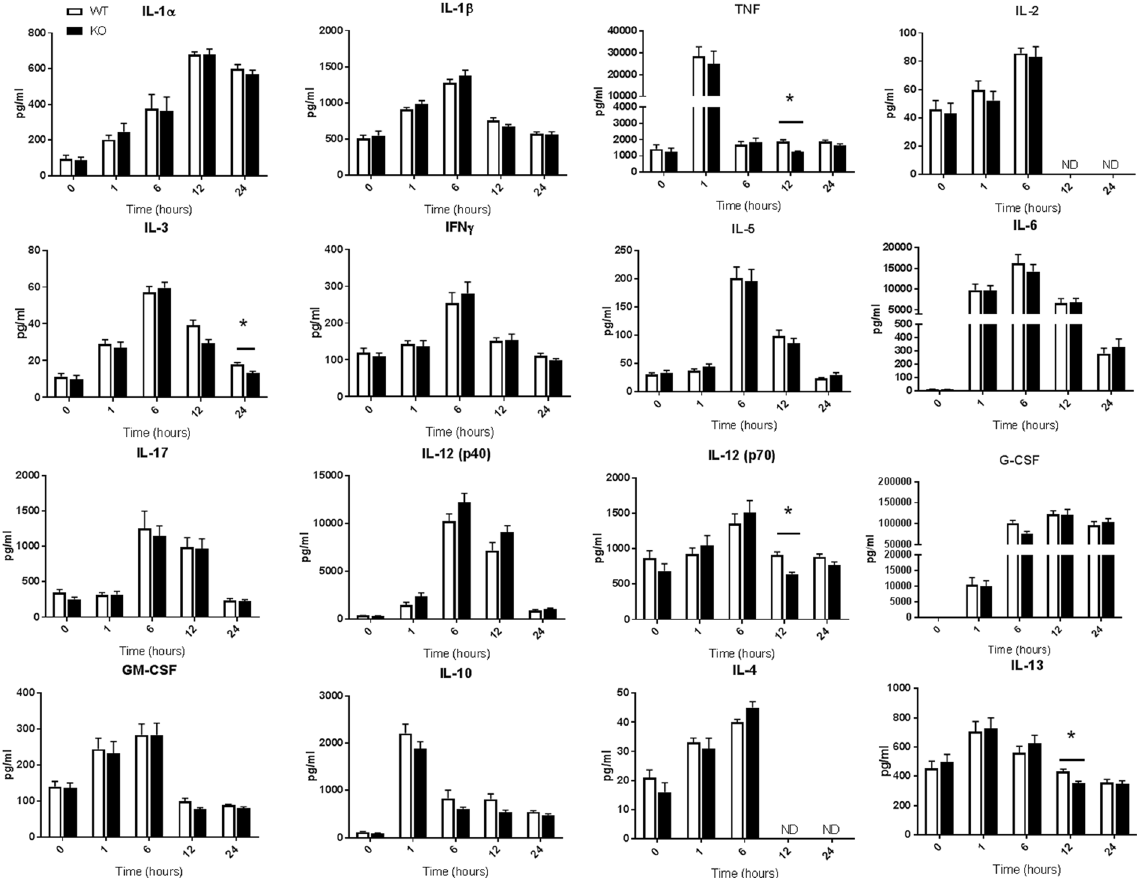
Figure 5. Serum cytokine levels in WT and ficolin KO mice after LPS challenge with a sublethal dose. Groups of WT and ficolin KO mice were intraperitoneally injected with LPS of a sublethal dose (2.5 mg/ kg). At indicated time points, blood was collected before the mouse was sacrificed. The serum concentration of inflammatory cytokines was measured by a multiplex Luminex assay; the data was obtained from two independent experiments per time point and represent mean ± SEM (n = 11 mice per group per time point). * p < 0.05 for WT to ficolin KO comparisons (unpaired two-tailed Student’s t test). ND = not